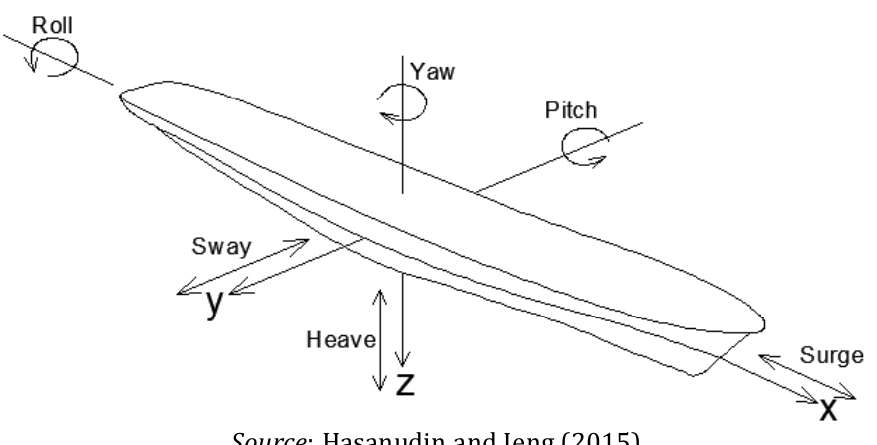
Figure 2: Directions of forces on